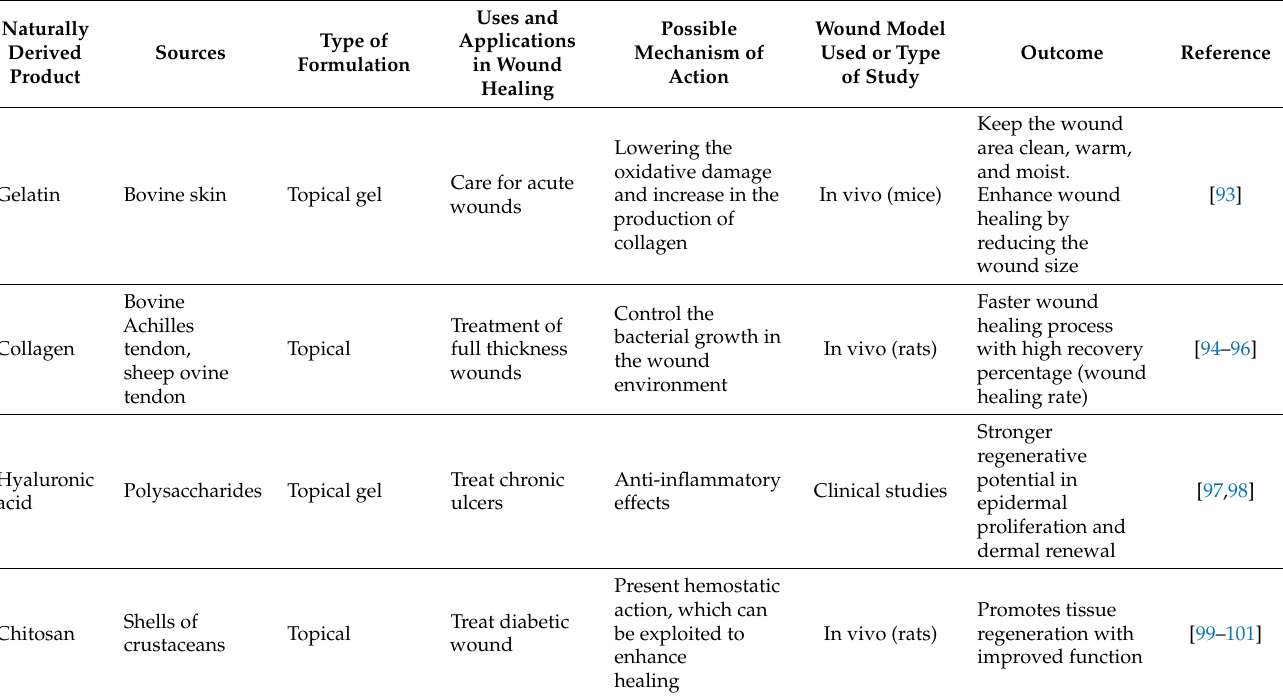
Table 3. Comprehensive details on the role of naturally derived products in wound healing